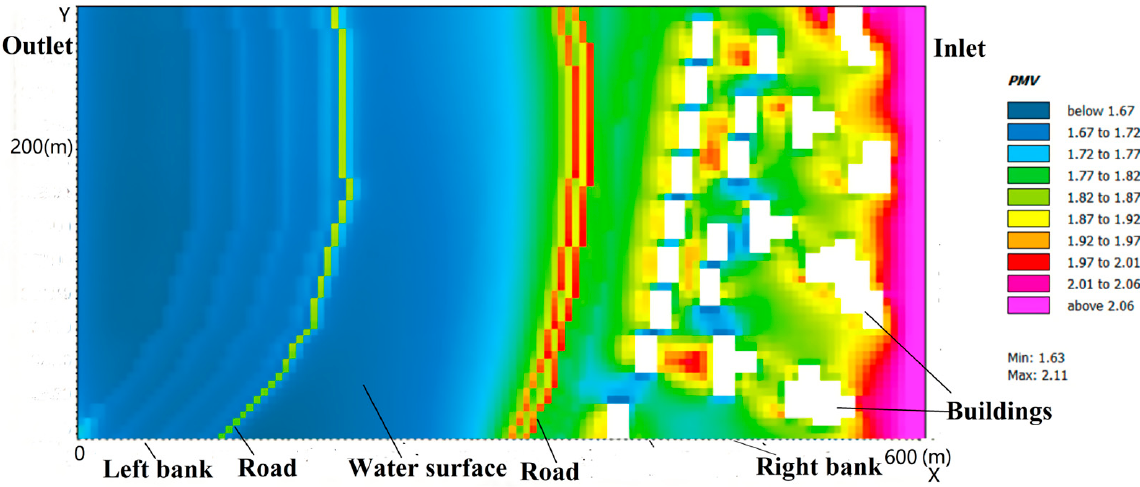
Figure 9. The outdoor PMV distribution of study area.